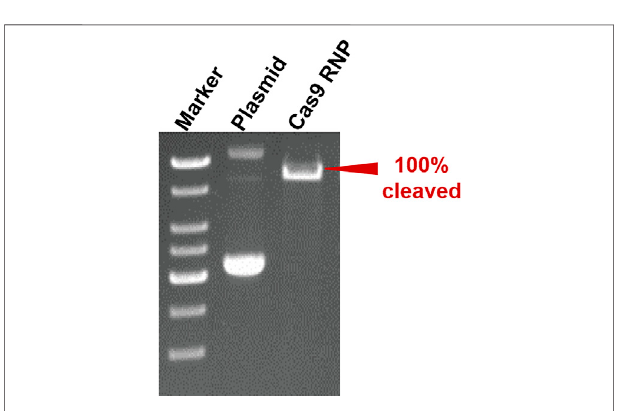
FIGURE3| ResultofcleavageofthetargetplasmidbyusingCas9RNPs (0.8% agarose gel).